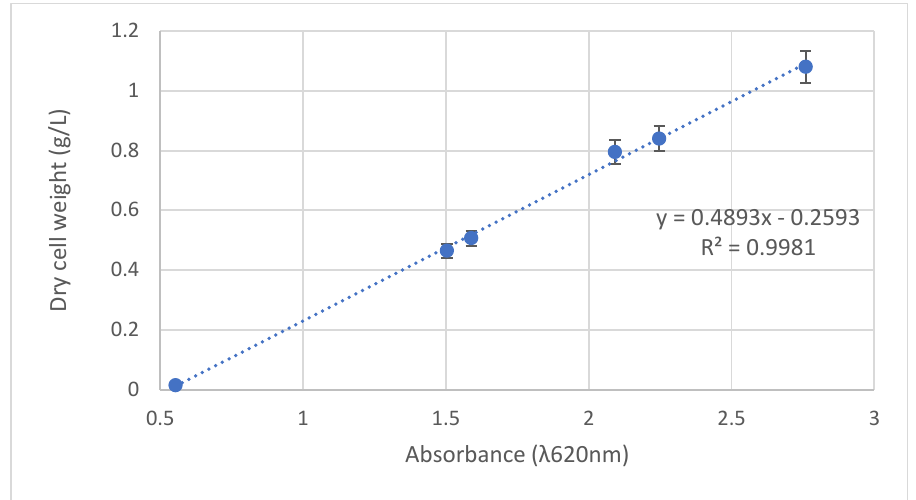
Figure 3. Harvested dry weight of L. reuteri DPC16 against the absorbance 620nm of the 24-h old culture; n = 3; error bars = standard deviations of replications; analyses of experiments were triplicate.